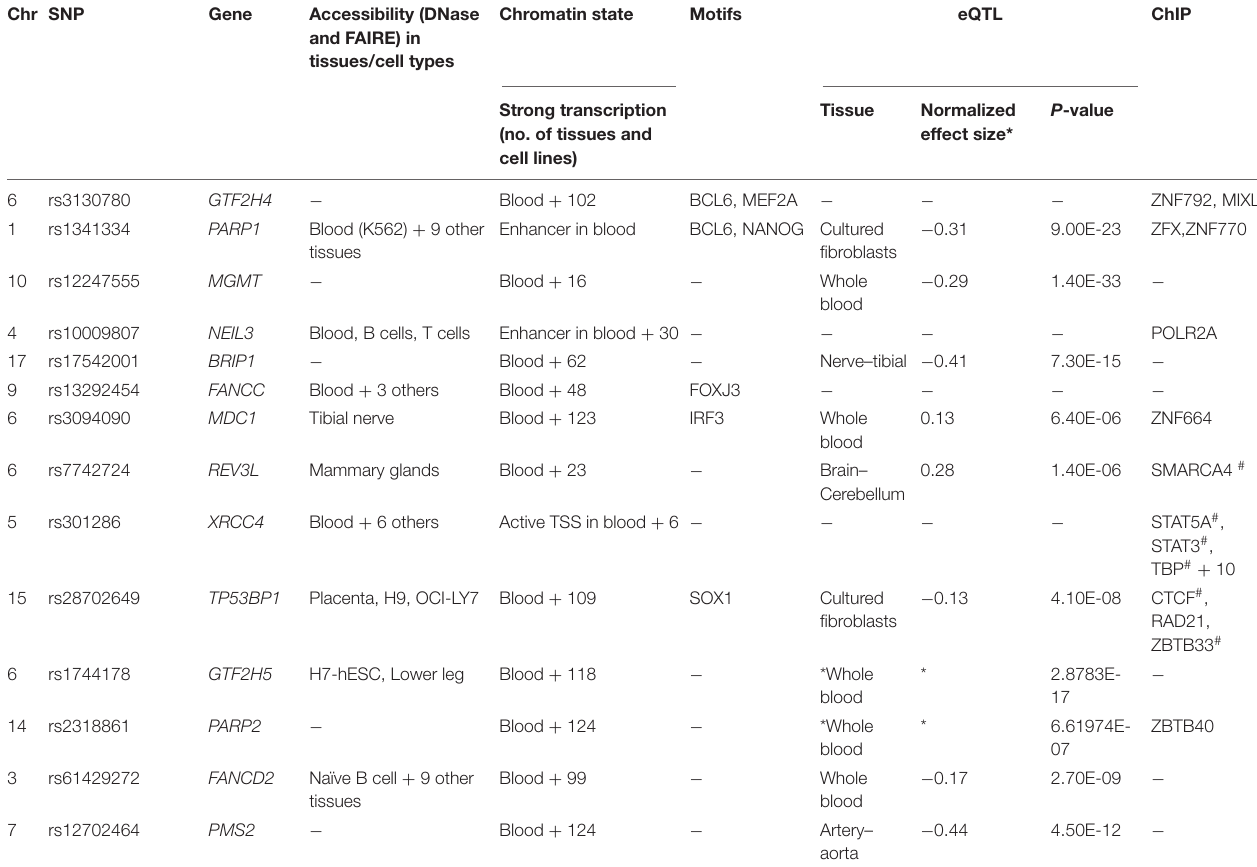
TABLE 4 | Regulome DB 2.0/GTex in silico analysis of associated variants. Chr SNP Gene Accessibility (DNase Chromatin state and FAIRE) in tissues/cell types